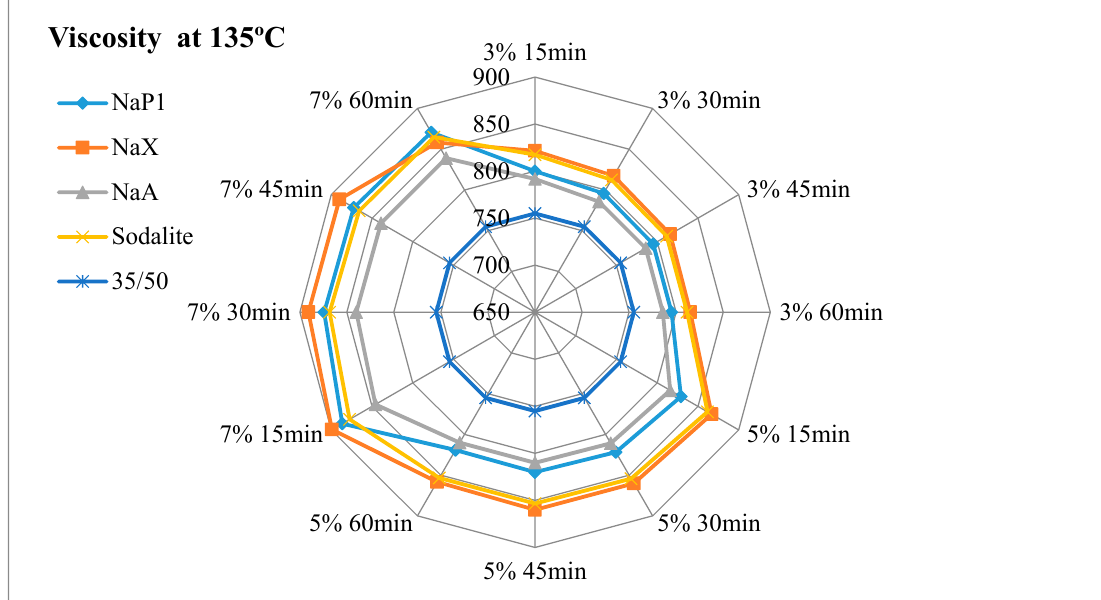
Figure 3. The results of dynamic viscosity tests for 35/50 asphalt with the addition of zeolites measured at 135 °C.